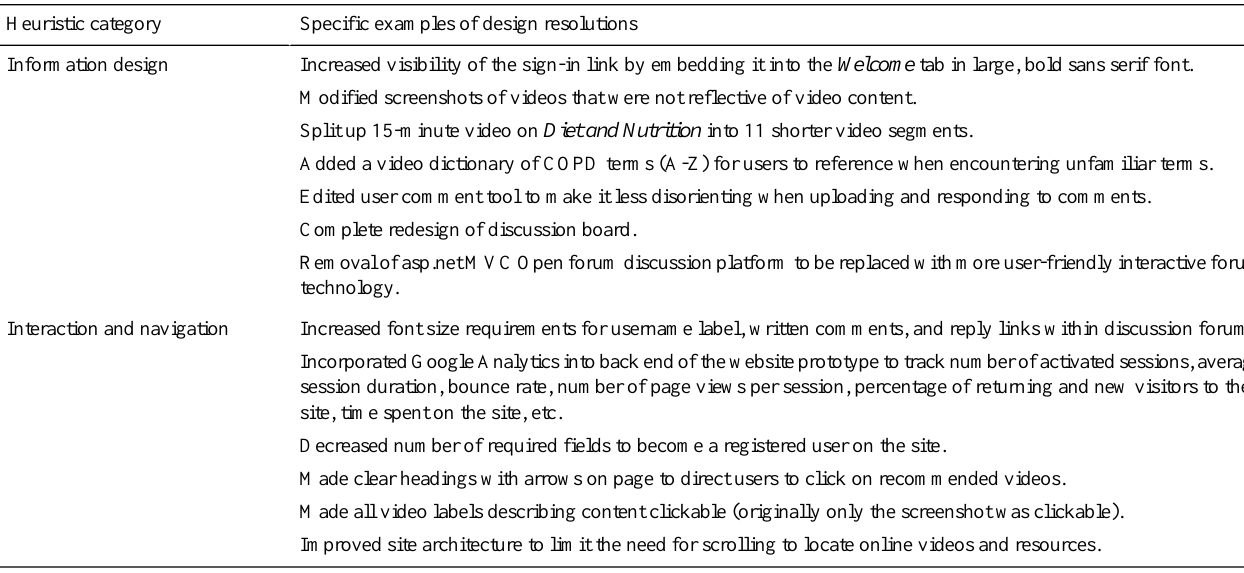
Table 7. Website prototype design resolutions made following usability testing with participants. Specific examples of design resolutionsHeuristic